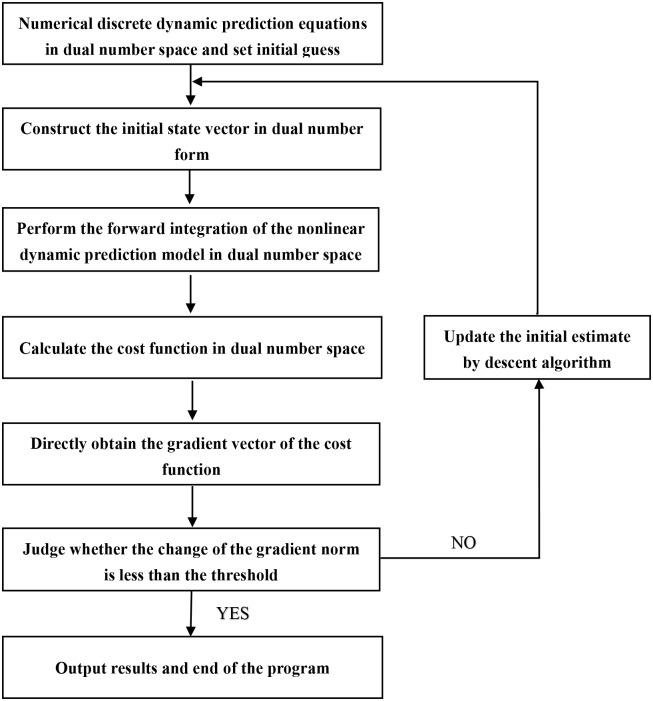
The flow diagram of data assimilation using the dual number AD method.